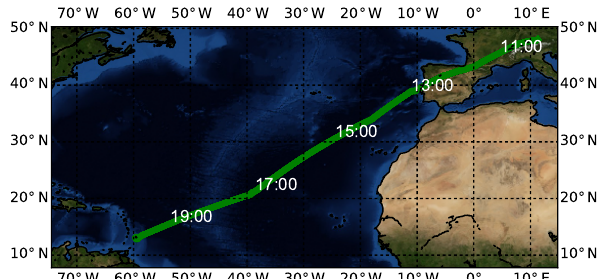
Figure 16. Map of the flight route of HALO on 19 December 2013 from Oberpfaffenhofen, Germany, to the island of Barbados. Indi- cated times are